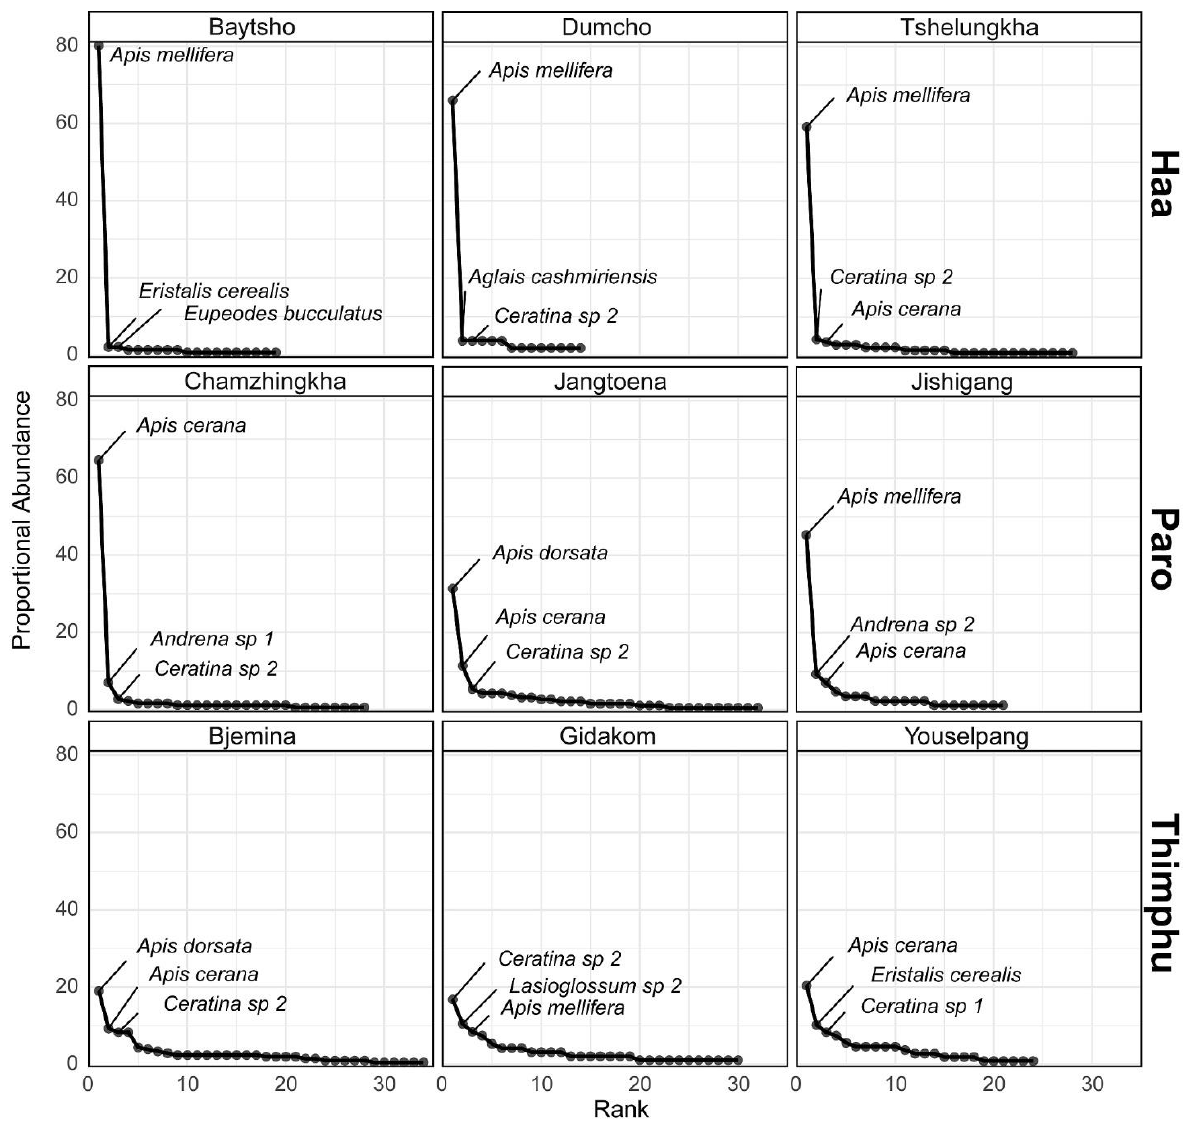
Figure 4 Whittaker plot showing relative species abundance and evenness per orchard site, top three most abundant species of the orchard are